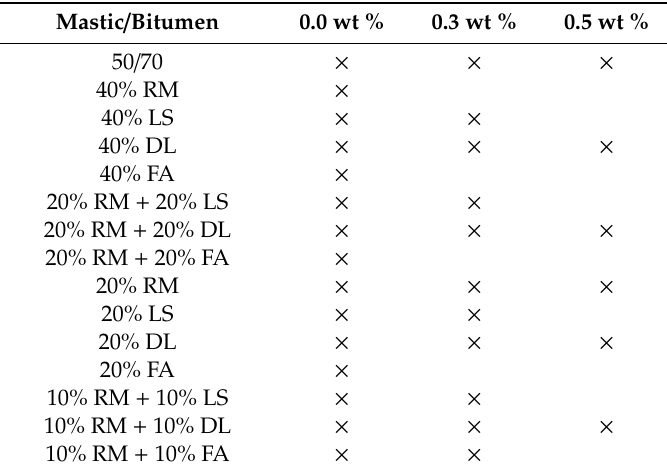
Table 4. Samples that required adhesion improver agent.